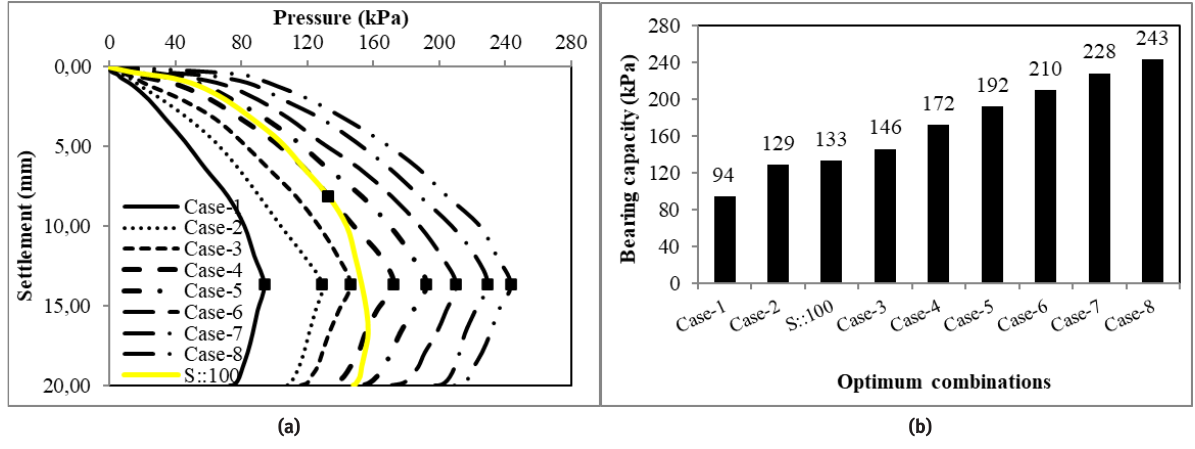
Figure 10: (a) Pressure–settlement curves and (b) bearing capacity values of two-layered soil for all cases at h/B=1.75 and of single-layer sandy soil for L/B=2.